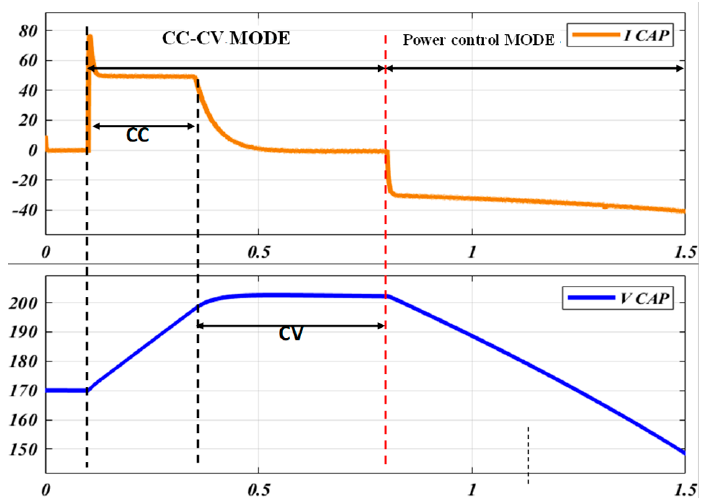
Figure 22. Simulation results of supercapacitor voltage/current.